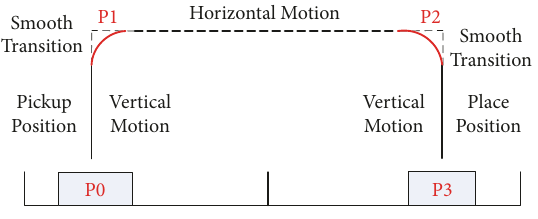
Figure 2: The door shape pick and place motion.